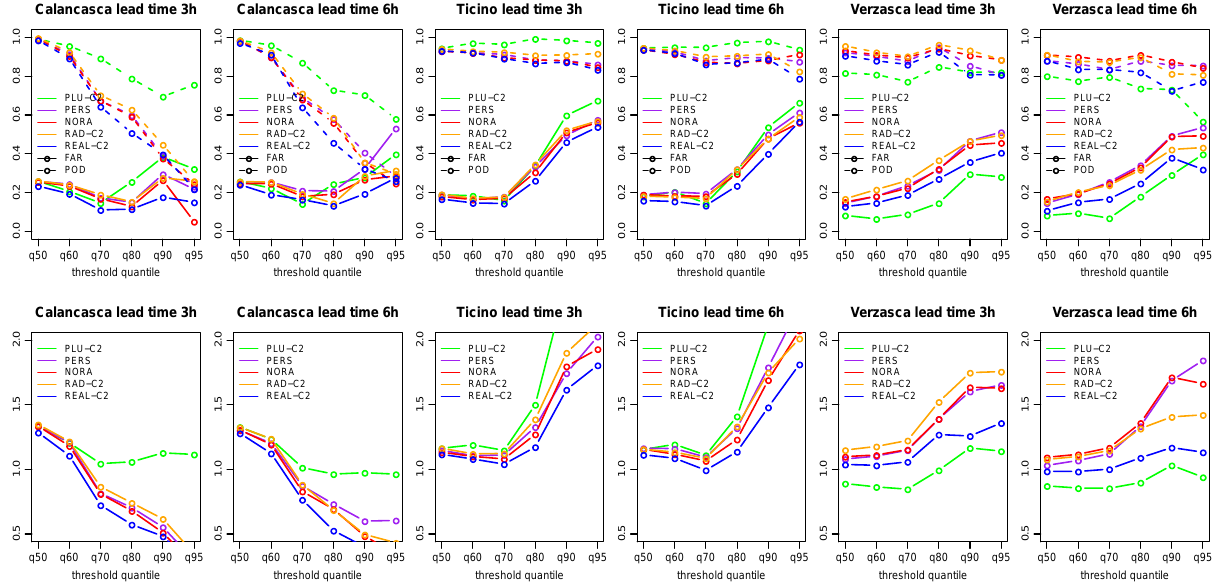
Fig. 6. Probability of detection (POD, dashed line), false alarm ratio (FAR, solid line) and BIAS (lower panel) for each catchment for the thresholds q50 to q95 with 3 and 6h lead time. Best FAR equals 0, best POD and BIAS equals